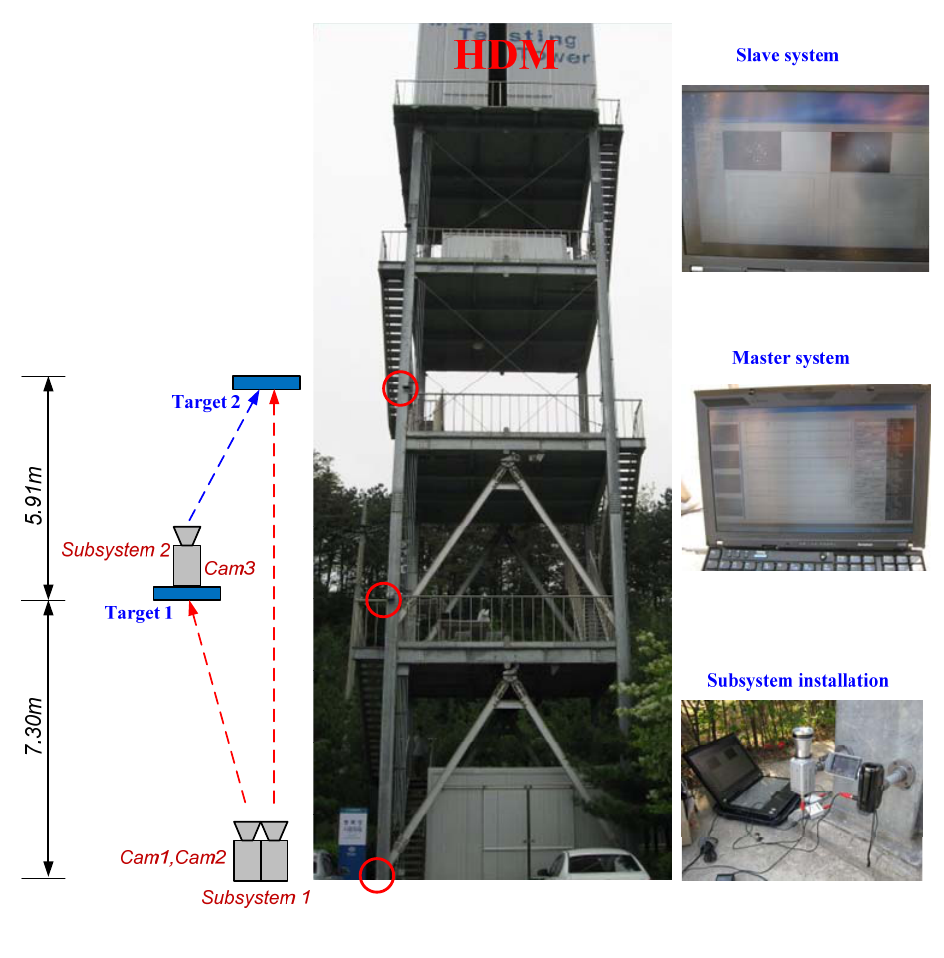
Figure 5. Field-test